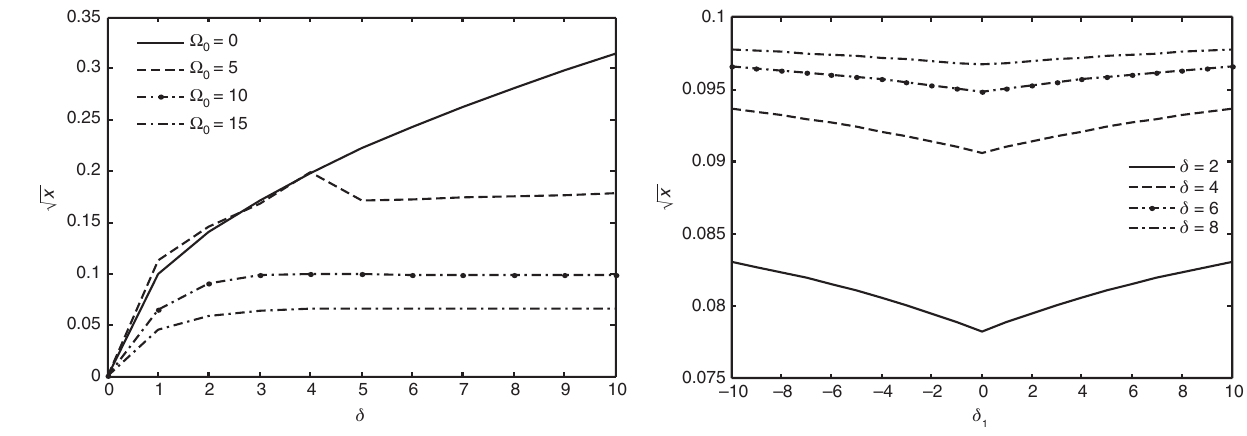
Figure 3: Variations of non-dimensional phase speed ( ) x against non-dimensional constant δ for impedance parameters δ = 10. δ 2